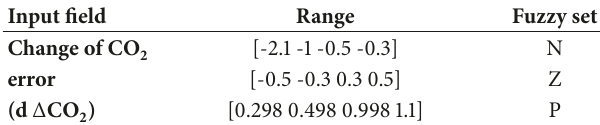
Table 7: MFs of change in Δ CO 2